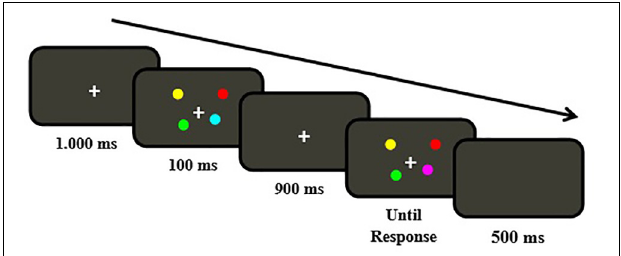
FIGURE 1 | Sequence of events of a trial in the change localization task.